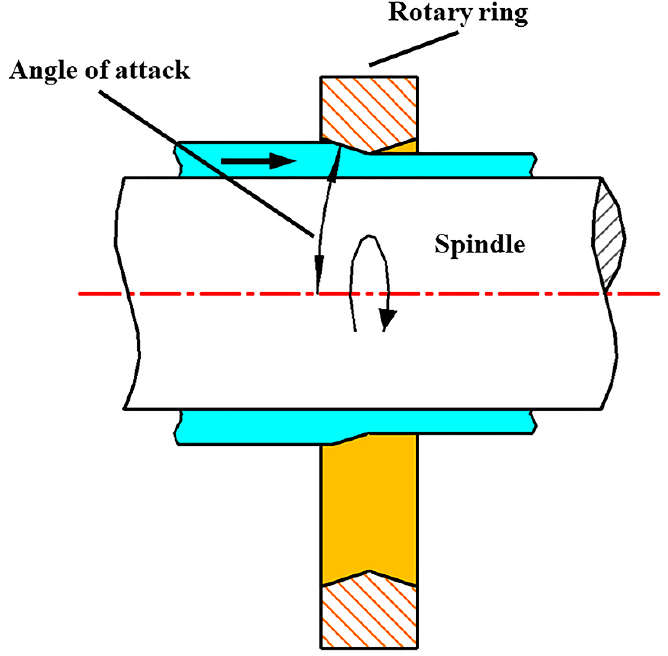
Figure 11. Diagram of angle of attack of rotary ring.